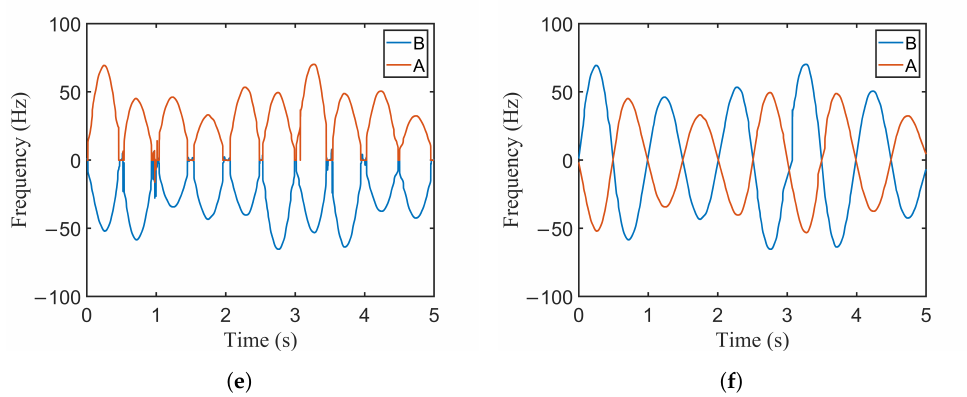
Figure 13. Results of the proposed algorithm on electromagnetic computational data. ( a ) Cone- shaped target model with three scattering centers. ( b ) The field of view angle change law. ( c ) Result by the STFT. ( d ) Result by the MSRT. ( e ) Ridge extraction. ( f ) Ridge segment